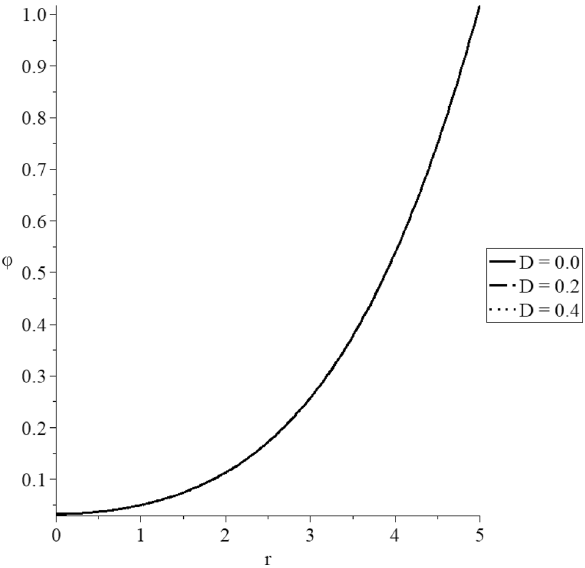
Figure 9. The conductive temperature increment distribution with various values of the mechanical damage parameter.